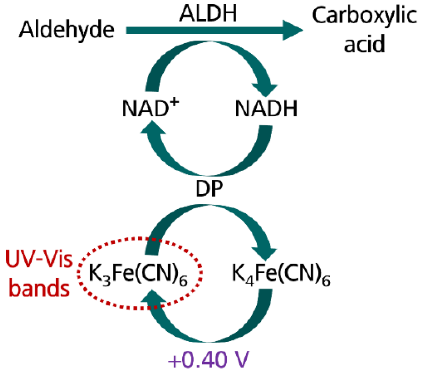
Figure 1. Enzymatic system formed by aldehyde dehydrogenase (ALDH), diaphorase (DP), β -nicotinamide adenine dinucleotide hydrate (NAD + ), and K 3 [Fe(CN) 6 ] which catalyzes the aldehyde oxidation to carboxylic acid.